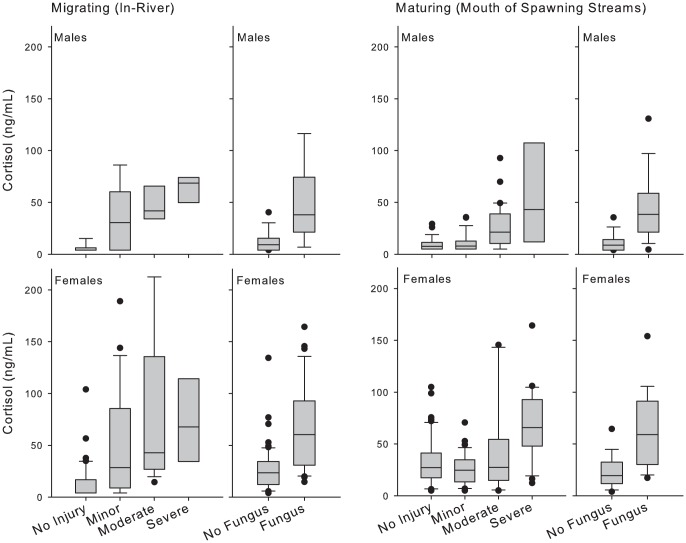
Plasma cortisol (ng/mL) in sockeye salmon sampled during in-river migration or at spawning stream mouths, according to severity of gillnet injury and presence of fungal infection (Saprolegnia spp.).Boxes mark the 25th–75th percentiles, the line marks the median, and whiskers mark 90th and 10th percentiles.